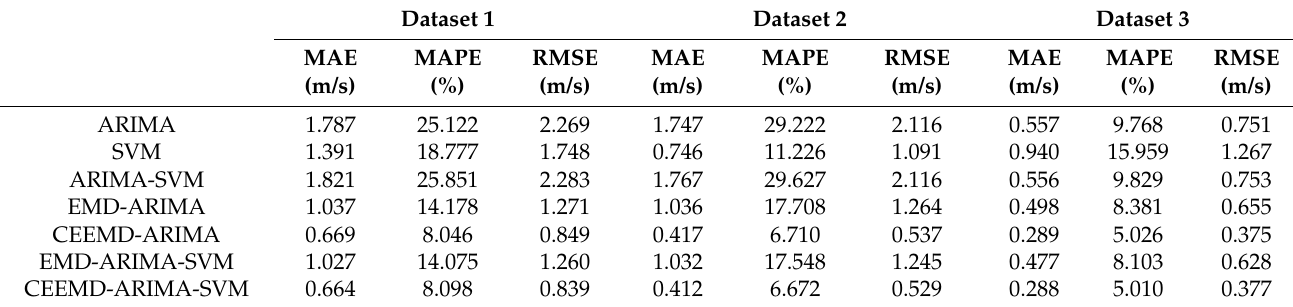
Table 2. Evaluation index results for the prediction